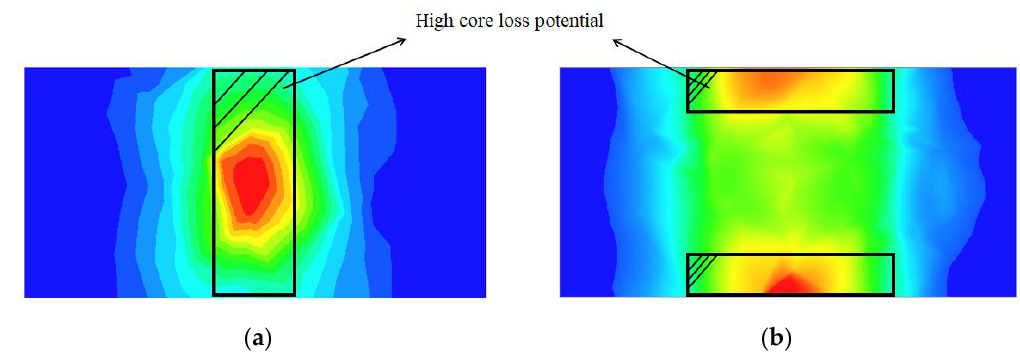
Figure 22. B-field distribution and high core loss potential areas in a DD coupler: ( a ) Primary core; ( b ) Secondary core.